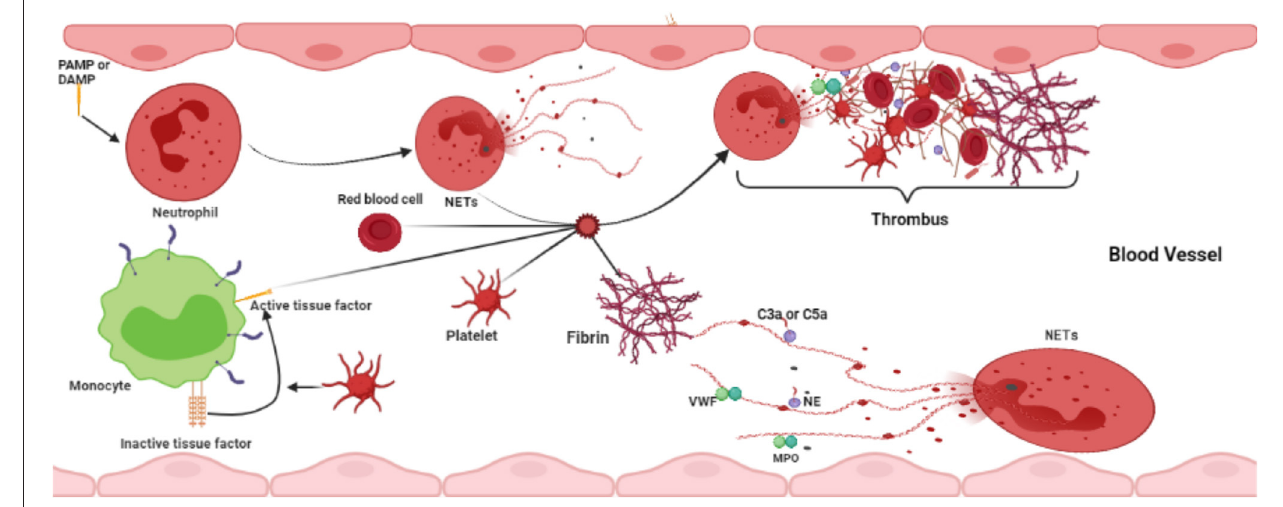
FIGURE 3 | Interaction between NETs and other blood cells in thrombosis